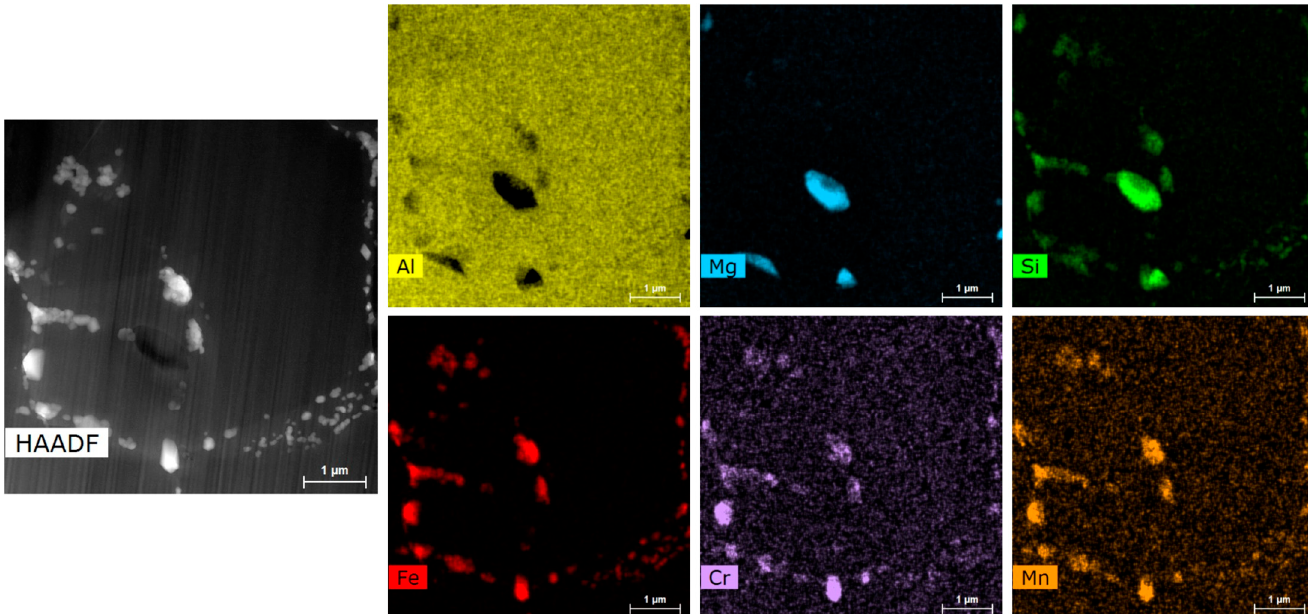
Figure 13. HAADF STEM image of discrete Fe-containing particles and larger Mg-Si particles at grain boundaries of heat-treated Al 6061 (540 °C for 1 h); EDS maps of Al, Mg, Si, Fe, Cr, and Mn.